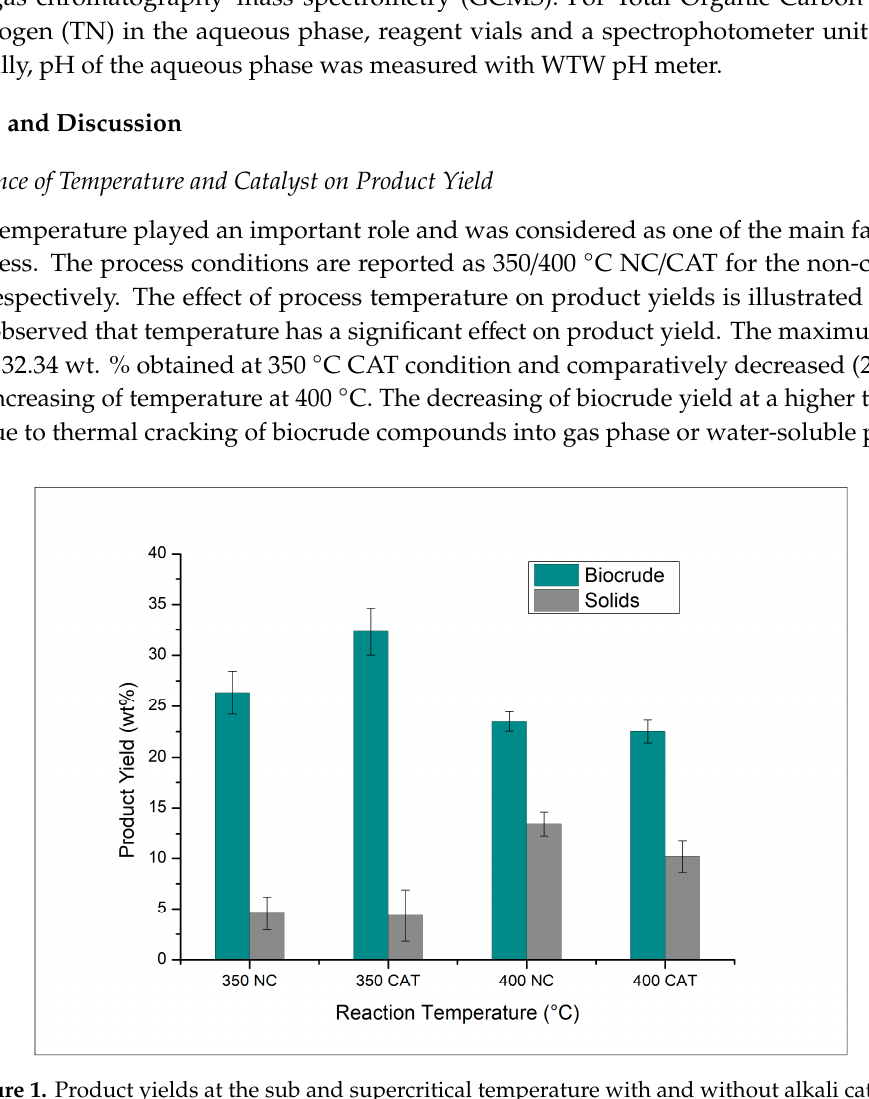
Figure 1. Product yields at the sub and supercritical temperature with and without alkali catalyst.